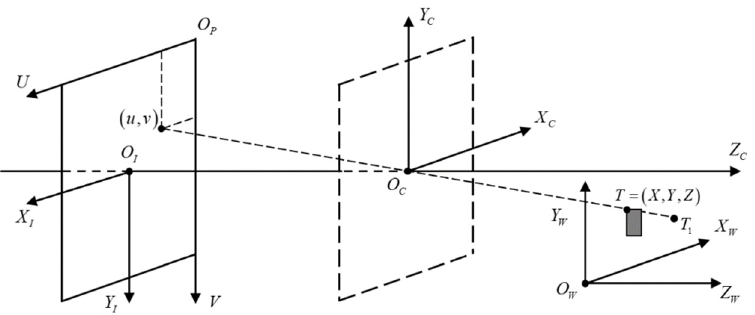
Figure 2. Camera imaging model.